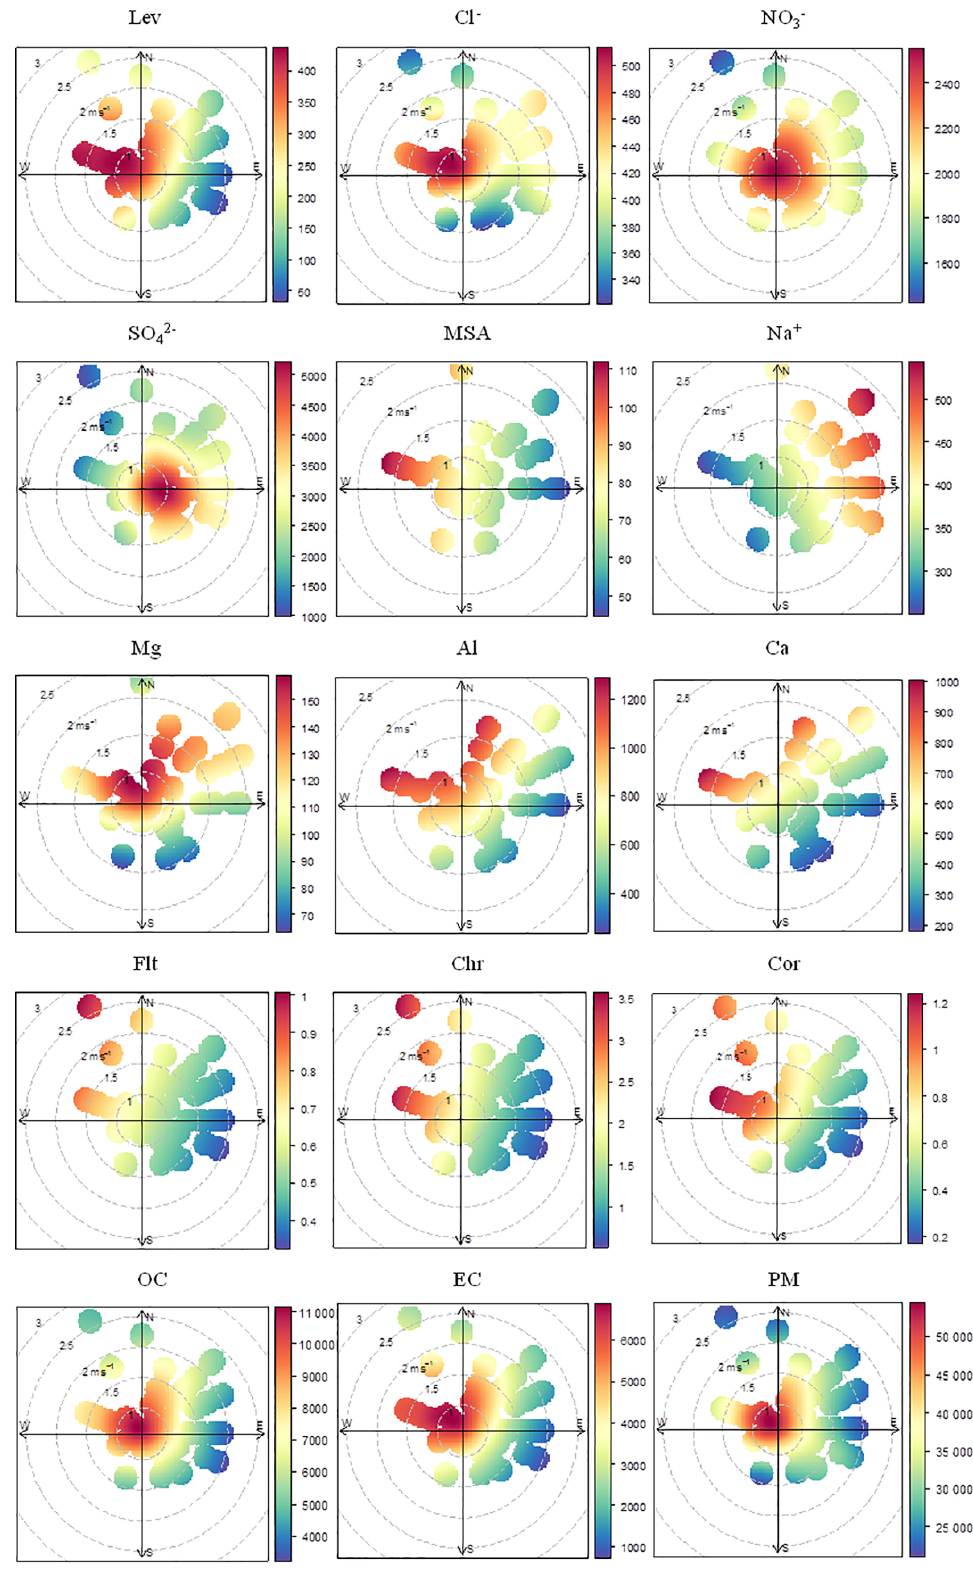
Figure 11. Polar plots for different species (ngm − 3 and ms − 1 )